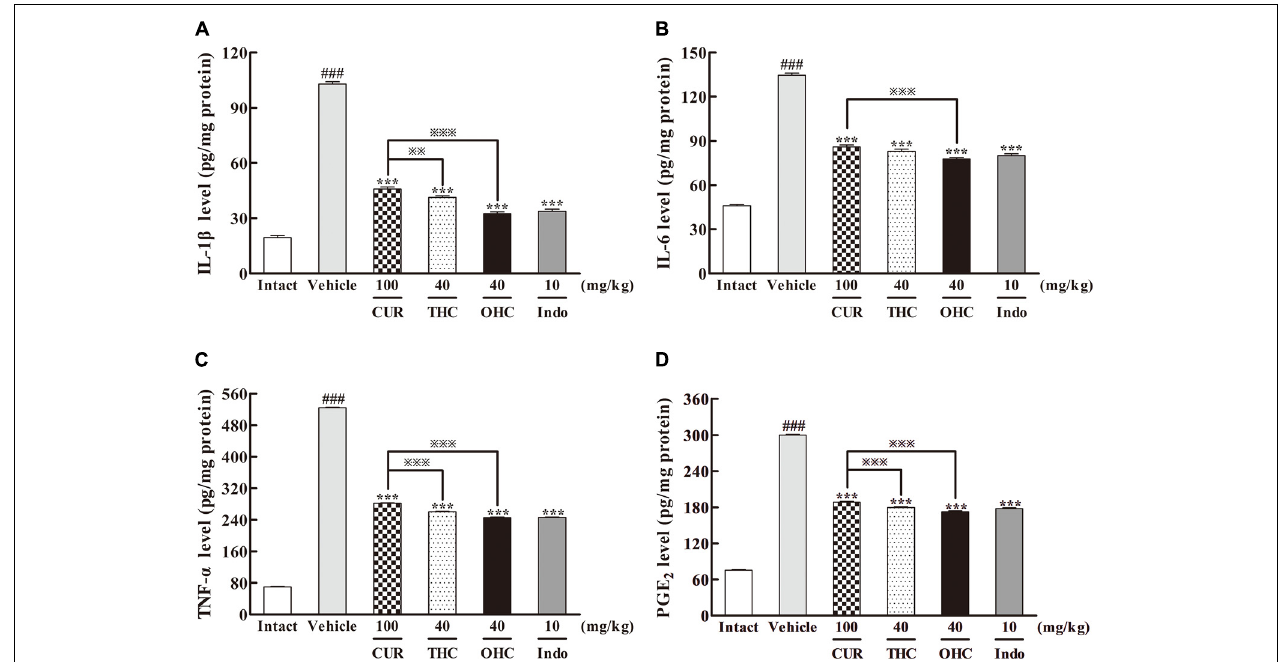
FIGURE 4 | Effects of THC and OHC on the levels of IL-1 β (A) , IL-6 (B) , TNF- α (C) , and PGE 2 (D) in the carrageenan-induced mouse paw edema. After administration with THC (40 mg/kg, i.g.), OHC (40 mg/kg, i.g.) or CUR (100 mg/kg, i.g.) for 7 days, the hind paws were removed and placed in cold PBS (1:9, v/w). After homogenization and centrifugation, the resulting supernatants were collected and analyzed by ELISA kits. Data were expressed as means ± S.E.M. ( n = 10), ### p < 0.001 vs. the intact control; ∗∗∗ p < 0.001 vs. the vehicle control; ※ p < 0.001 vs. the CUR group. Significant differences between groups were determined by ANOVA and Dunnett’s post hoc